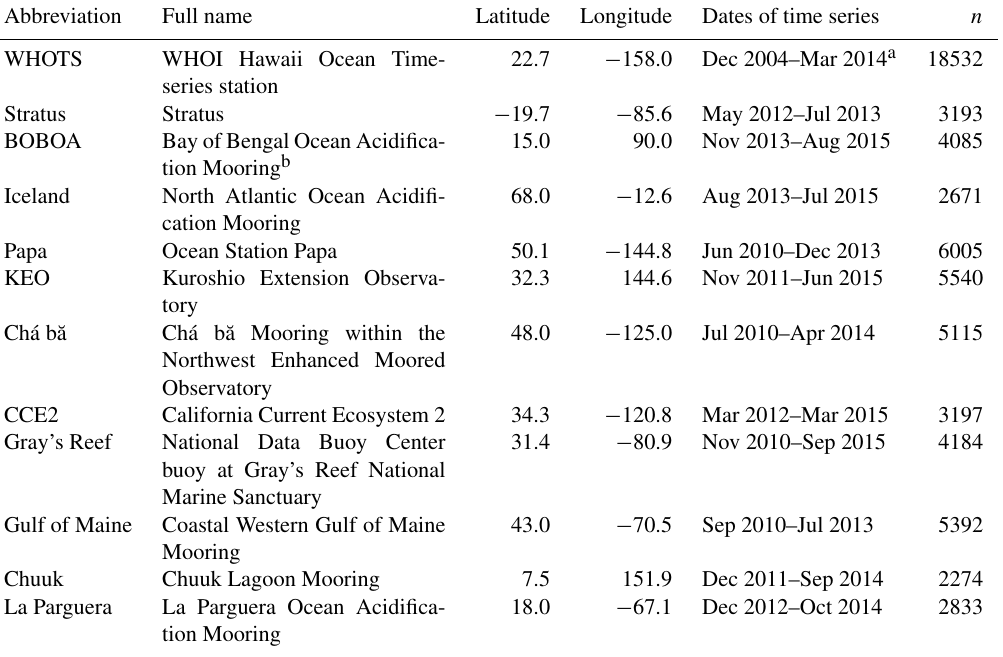
Table 1. Details on each surface seawater p (CO 2 ) and pH mooring time series including abbreviation, name, coordinates, and dates of time series. n is the total number of 3-hourly samples for each pH and (cid:127) arag time series. Finalized data sets can be found organized by mooring location by navigating through the clickable CO 2 data portal map at